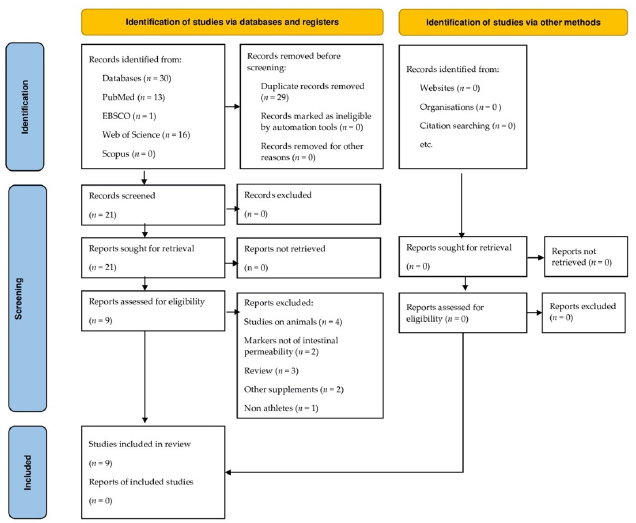
Figure 1. The flowchart figure was drawn according to the statement of the PRISMA protocol